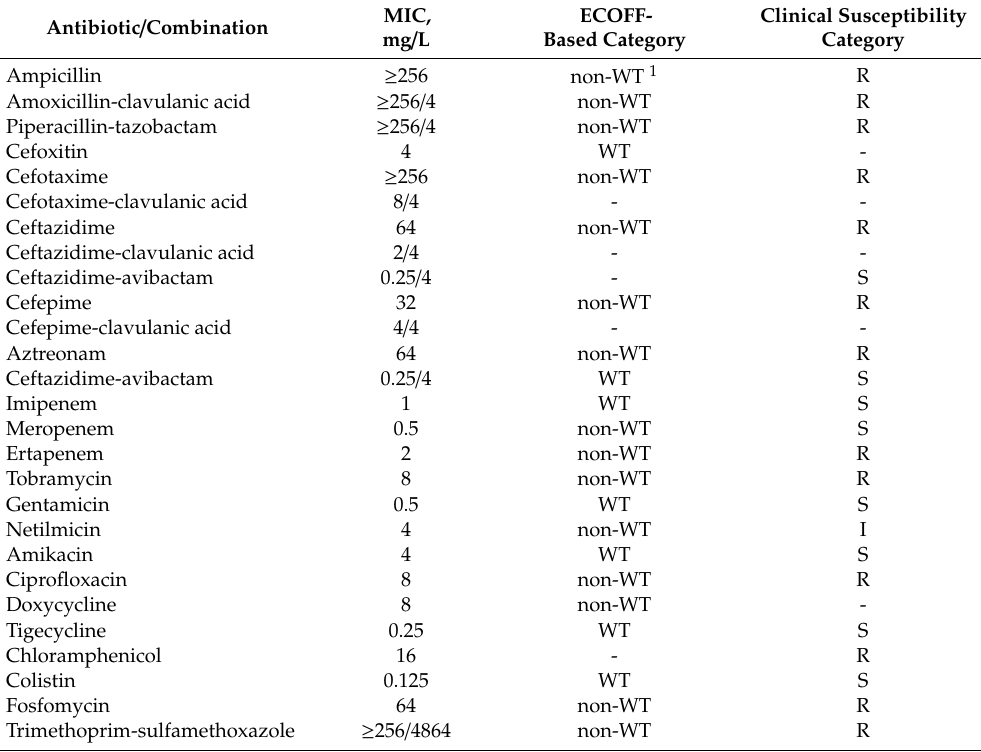
Table 1. Antibiotic resistance phenotype of